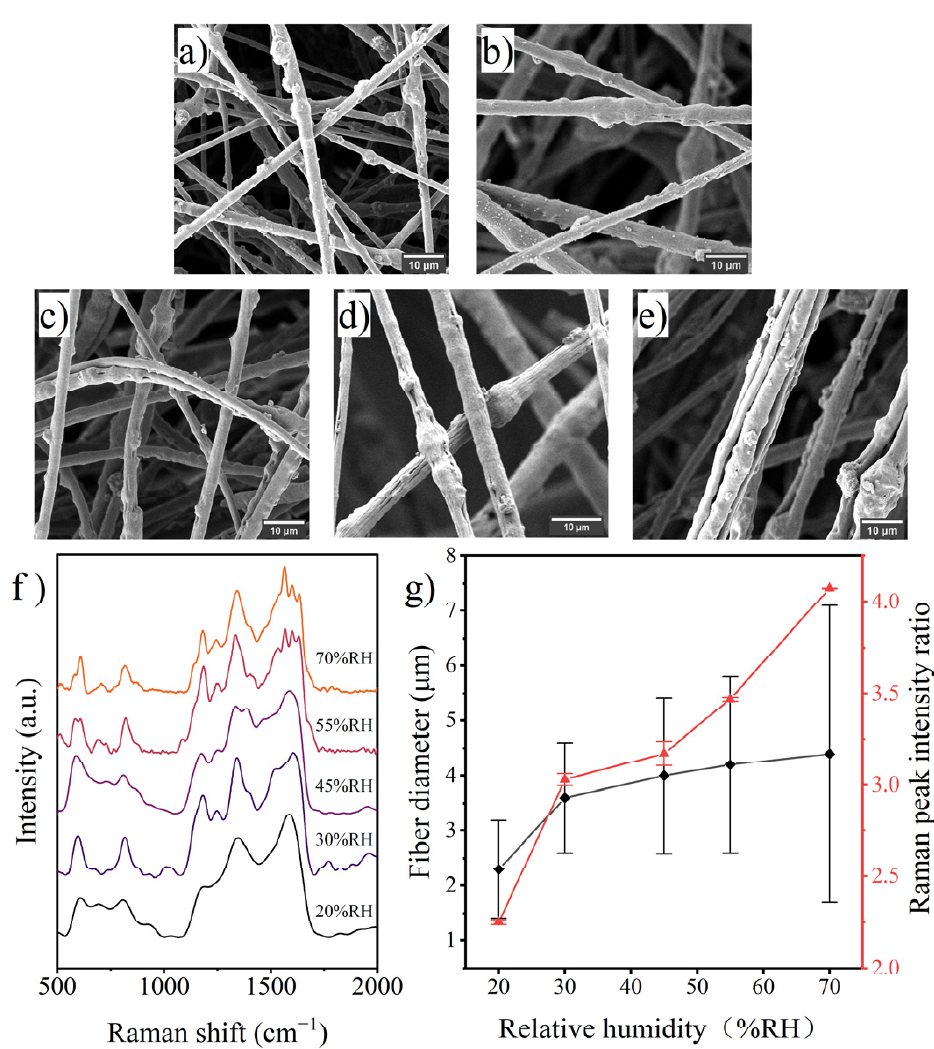
Figure 7. SEM images of fibers prepared with various humidity: ( a ) 20% RH, ( b ) 30% RH, ( c ) 45% RH, ( d ) 55% RH, ( e ) 70% RH; ( f ) Raman spectra of the fibers and ( g ) effects of humidity on fiber diameter and surface PANI occupancy.